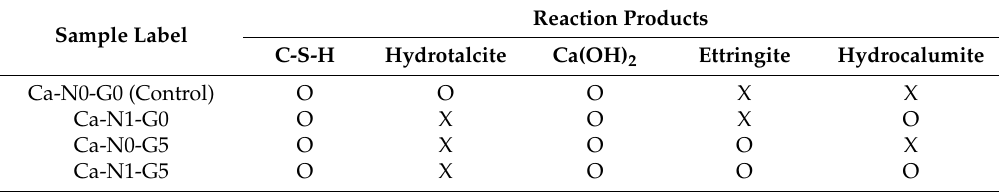
Figure 3. X-ray diffraction (XRD) patterns of hardened pastes at ( a ) 7 and ( b ) 28 days. Note that the reference XRD pattern for calcium silicate hydrate (C-S-H) was taken from a 22-year-old β -C 2 S paste from an earlier study after removing the peaks of Ca(OH) 2 [35]. The numbers in parentheses indicate the International Center for Diffraction Data (ICDD) and Inorganic Crystal Structure Database (ICSD) reference numbers for the identified phases. Table 4. Identified reaction products of hardened paste samples (O: Formation, X: No formation).